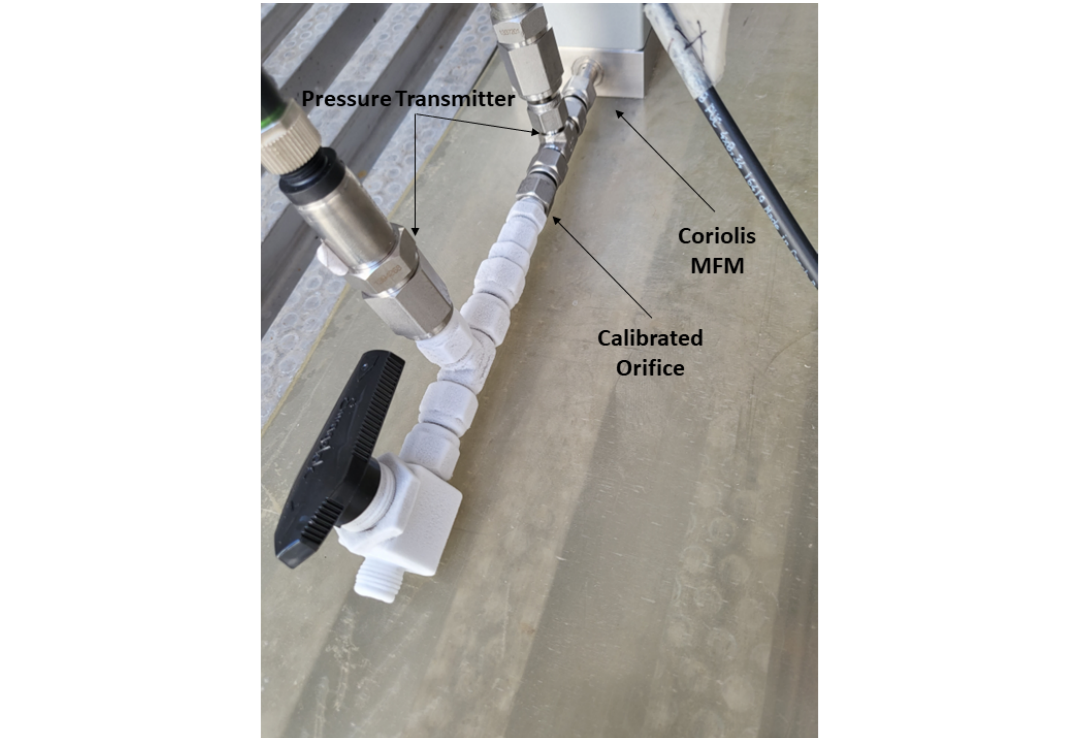
Figure 8. Image of the calibrated orifice at the end of a liquid draining test.